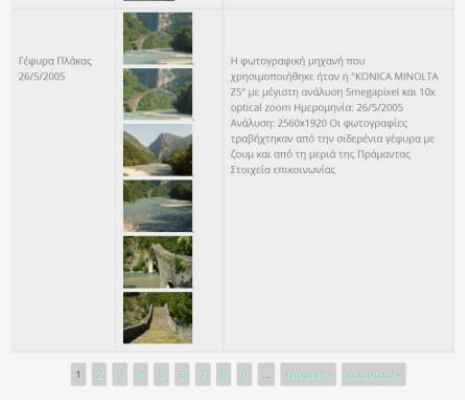
Figure 5: Image submission